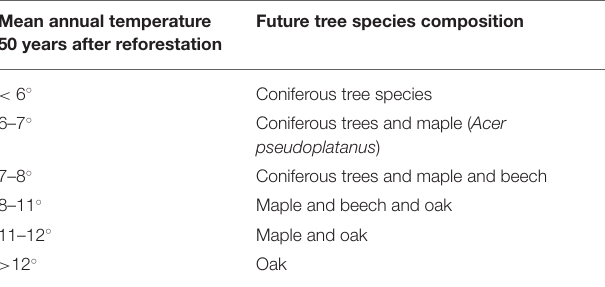
TABLE 1 | Replacement of coniferous tree species based on the expected mean annual temperature in 50 years after